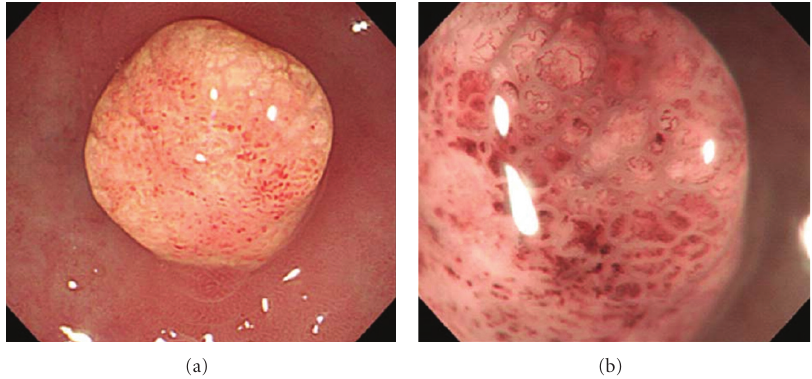
Figure 1: Endoscopic appearance of the pedunculated gastric hyperplastic polyp (7mm in size) arising from the greater curvature of the antrum. (a) The polyp had whitish yellow granules. (b) Magnification narrow-band imaging endoscopy revealed long microcapillaries in the polyp but did not reveal disappearance of the mucosal microstructure or irregular branched capillaries ( × 50).